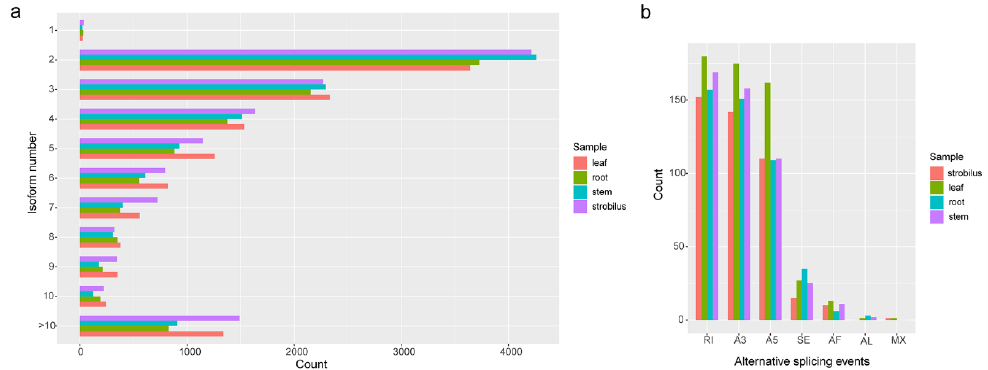
Figure 5. Identification of alternative splicing (AS) events. ( a ) The distribution of isoform numbers for UniTransModels in four organs; ( b ) the number of AS events in four organs.